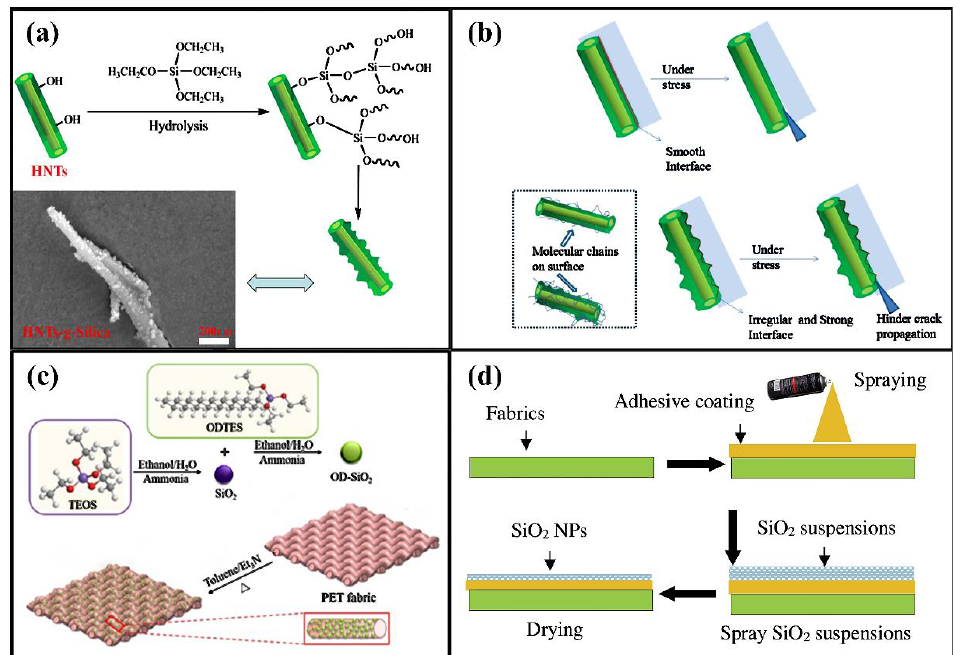
Figure 6. Diagram of the effect of SNs on the mechanical properties of PET. ( a ) Schematic diagram of preparation and morphology of HNTs-g-SiO 2 . Adapted with permission from [79]. Copyright 2017, Elsevier. ( b ) Improved impact strength mechanism model diagram. Adapted with permission from [79]. Copyright 2017, Elsevier. ( c ) Schematic illustration of the preparation of n-octadecyltri- ethoxysilane modified SNs and coated PET fabric. Adapted with permission from [180]. Copyright 2020, Korean Society of Industrial Engineering Chemistry. ( d ) Method schematic of hydrophobic SNs coated PET fabric. Adapted with permission from [181]. Copyright 2020, Elsevier.